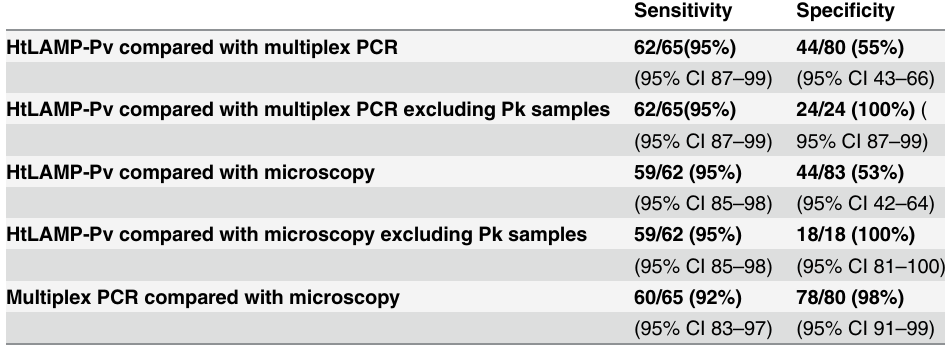
Table 6. Sensitivity and specificity of HtLAMP-Pv for P . vivax in symptomatic patients in Sabah with P . falciparum , P . vivax and P . knowlesi . 149 filter paper samples were tested by HtLAMP-Pv; 4 samples were excluded due to a lack of PCR and microscopy data. Among the 145 samples, PCR confirmation of species was as follows: n = 64 P . vivax n = 56 P . knowlesi , n = 17 P . falciparum , n = 7 P . malariae and n = 1 mixed P . vivax/P . knowlesi